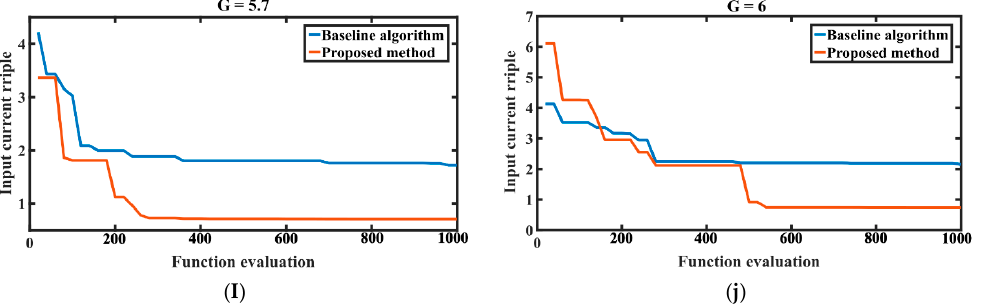
Figure 4. Convergence graphs of proposed (red) and baseline (blue) methods with different gain values. ( a ) G = 3.4, ( b ) G = 3.6, ( c ) G = 3.8, ( d ) G = 4, ( e ) G = 4.3, ( f ) G = 4.7, ( g ) G = 5, ( h ) G = 5.3, ( I ) G = 5.7, and ( j ) G = 6.